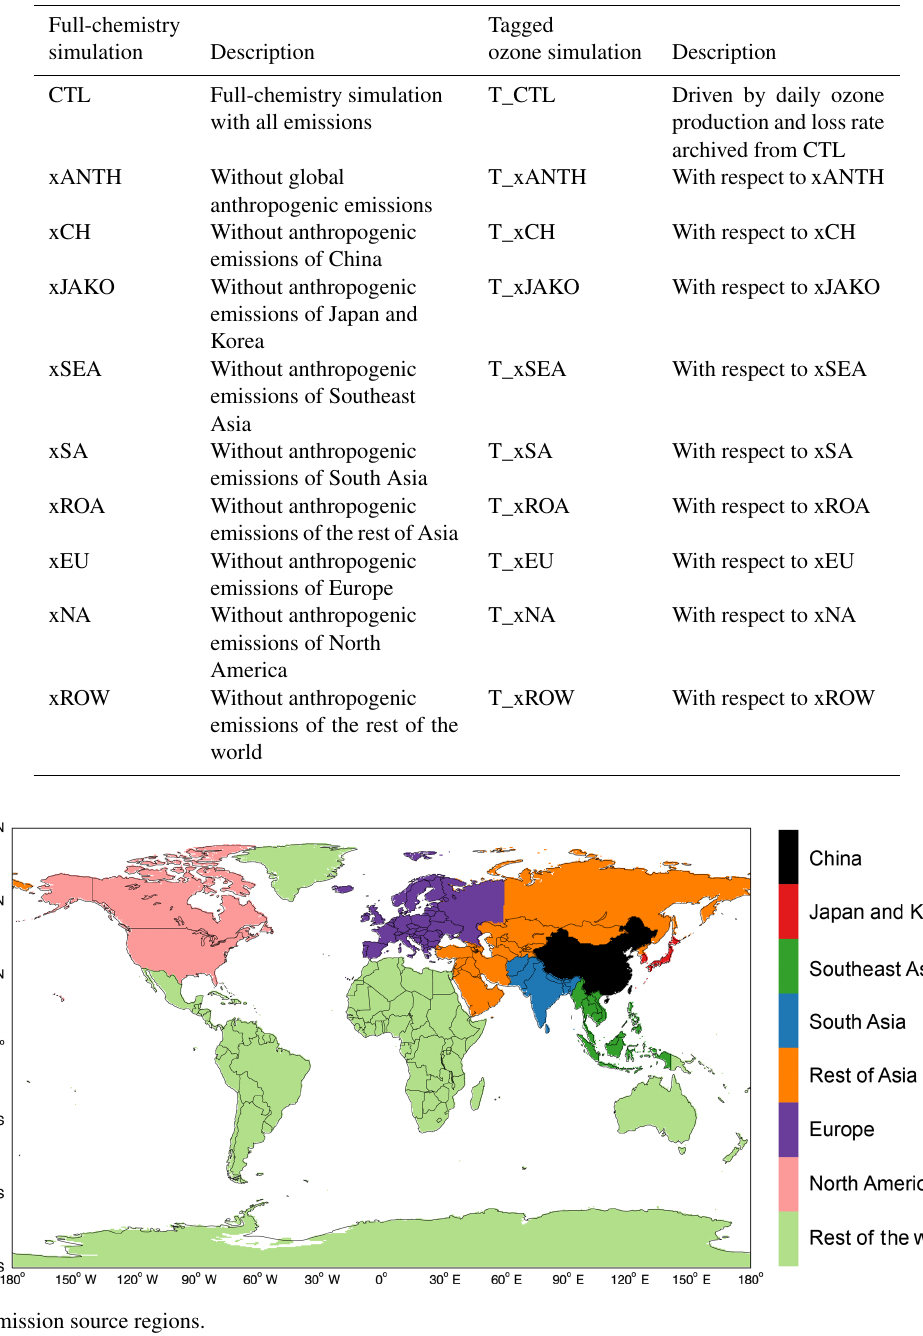
Figure 1. Eight emission source